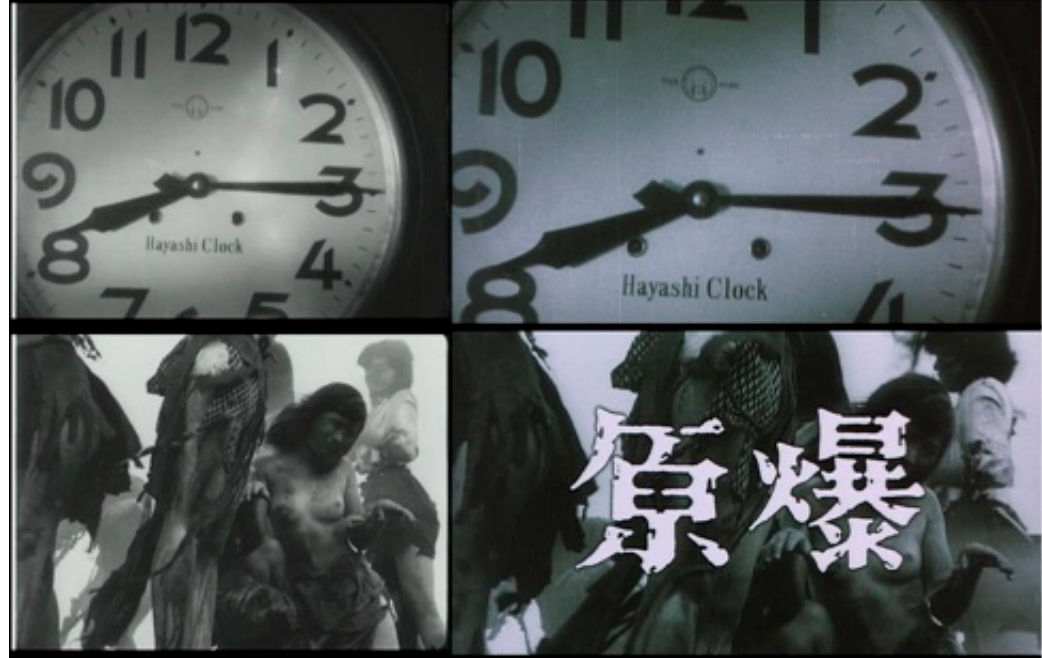
Figure 6. Children of Hiroshima (Shind ō Kaneto, 1952) / A Postcard (Shind ō Kaneto, 2011) .